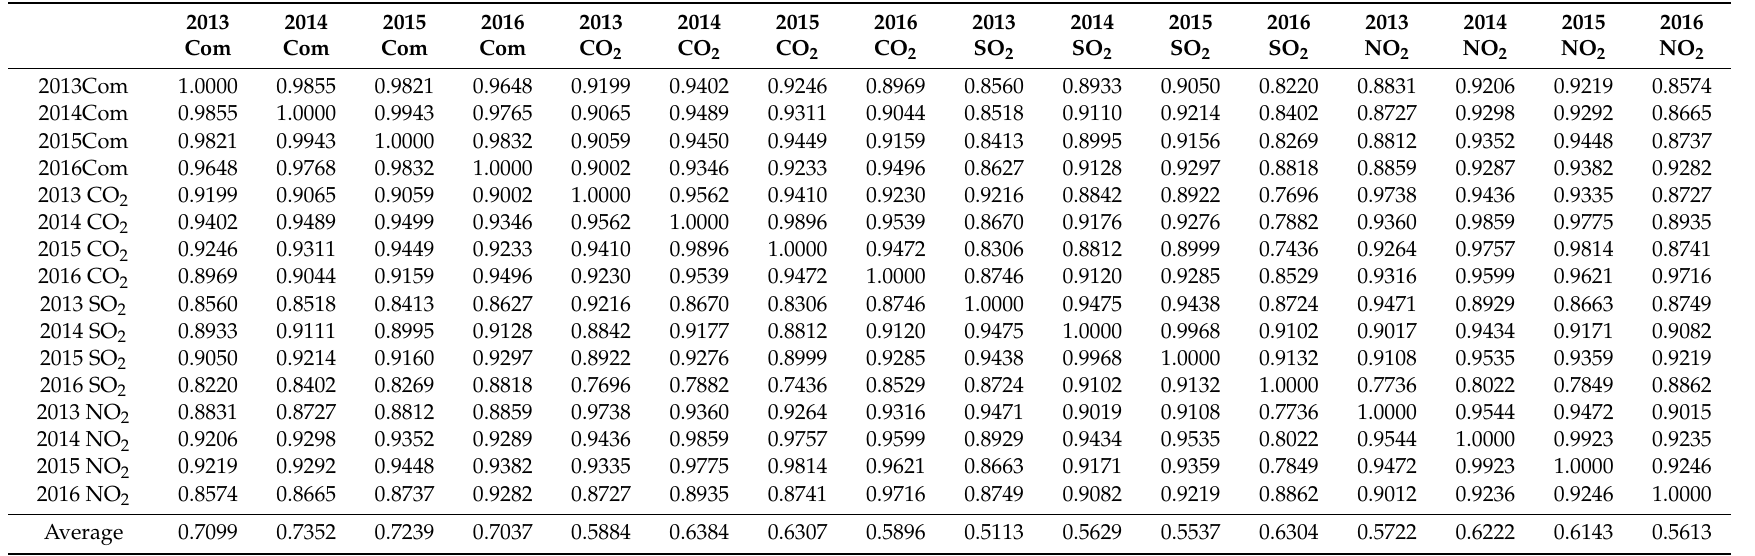
Table 7. Com, CO 2 , SO 2 , and NO 2 E ffi ciency Correlation Tests from 2013 to